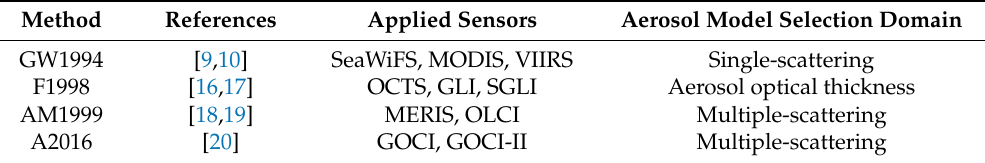
Table 1. Aerosol reflectance correction schemes based on the black pixel